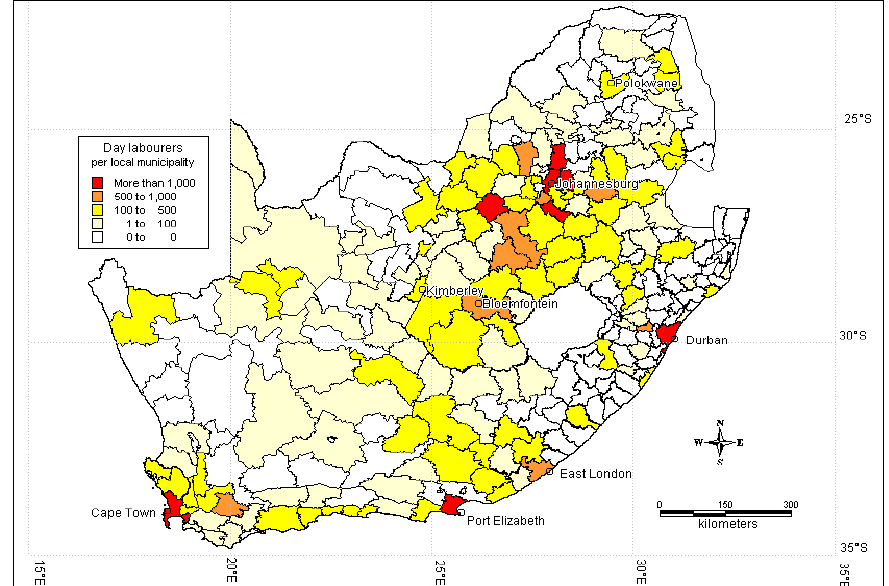
The spatial distribution of day labourers in South Africa,